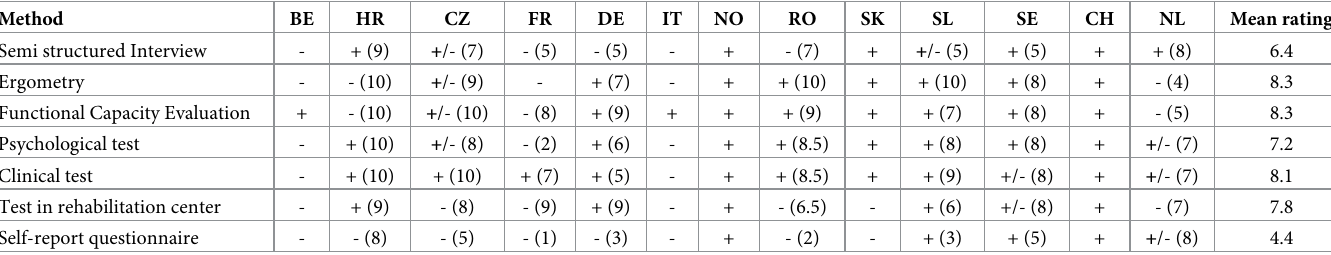
Table 3. Methods (and expert suitability rating: 0–10) used to assess work endurance in European countries (n = 13).